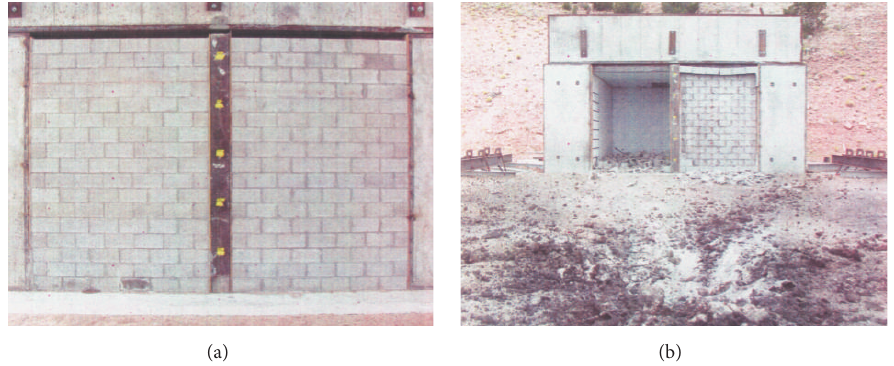
Figure 2: Stanley et al.’s [7] blast test (a) before blast test and (b) after blast